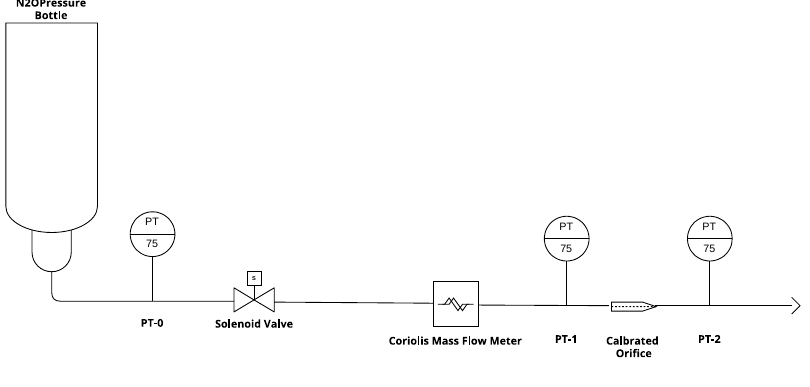
Figure 4. Experimental setup 1 P&ID Diagram, configuration for a liquid drain